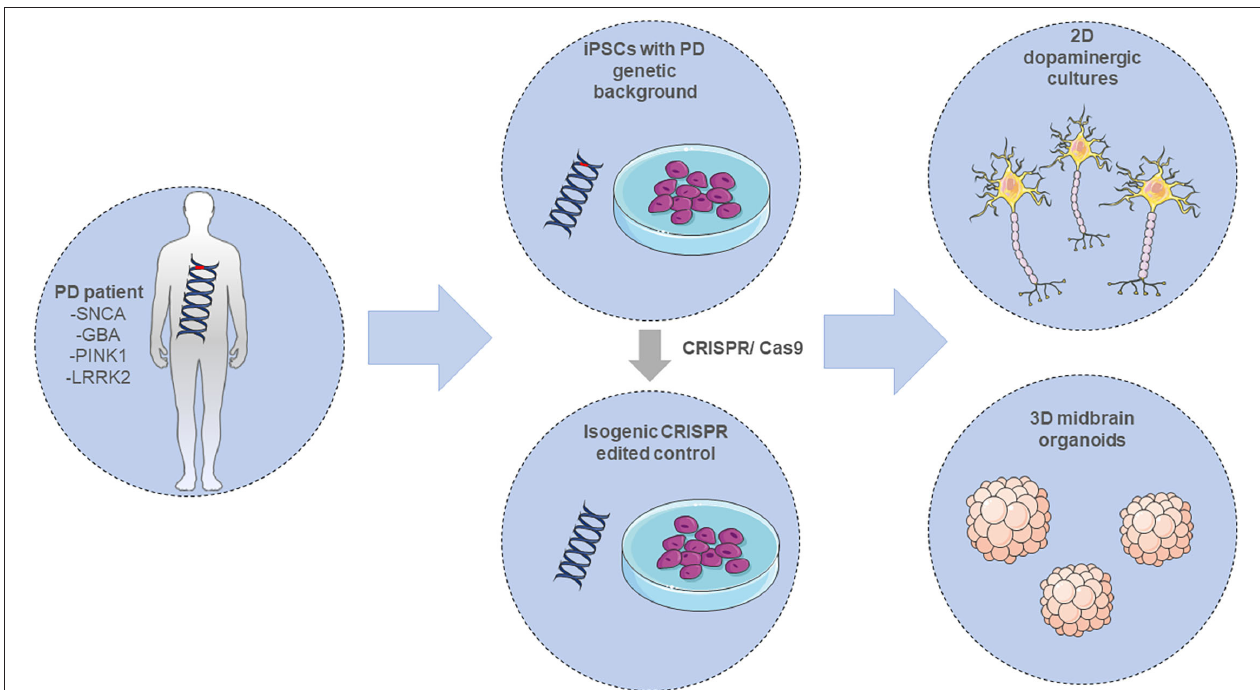
FIGURE 3 | Modeling PD employing iPSC-derived in vitro systems. Adult differentiated cells, either from PD patients carrying a mutation in the SNCA , GBA , PINK1 , or LRRK2 gene amongst others, or CRISPR-edited isogenic controls, are reprogrammed into induced pluripotent stem cells (iPSCs). These cells can be further differentiated into 2D or 3D neuronal in vitro cultures for investigating PD pathology. The illustration was created using images from